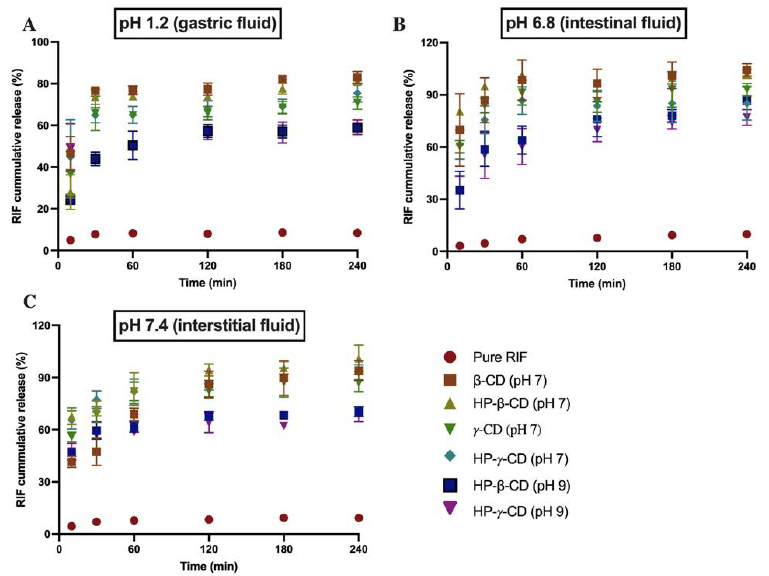
Figure 11. Dissolution profile of pure RIF and inclusion complexes in different pH of release media, ( A ) pH 1.2 or gastric fluid, ( B ) pH 6.8 or intestinal fluid, and ( C ) pH 7.4 or interstitial fluid (means ± SD, n = 3).